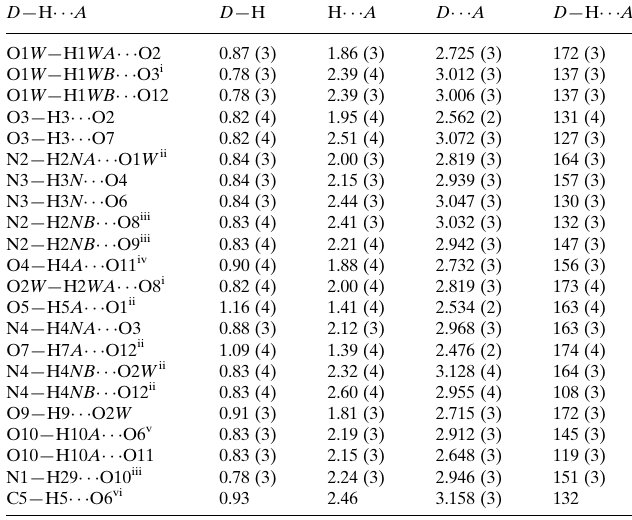
Hydrogen-bond geometry (A˚ , (cid:4)